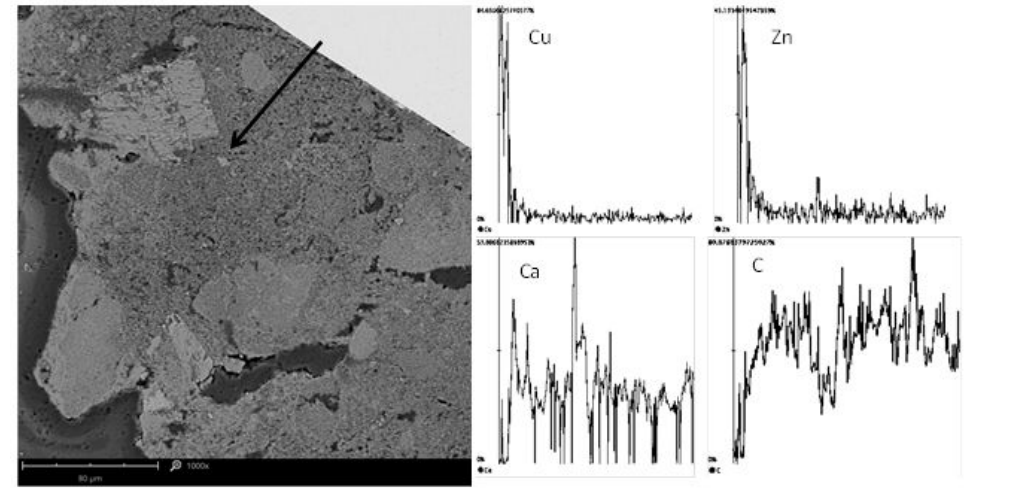
Figure 6. SEM micrograph of brass – lime interface. The arrow indicate line scan.